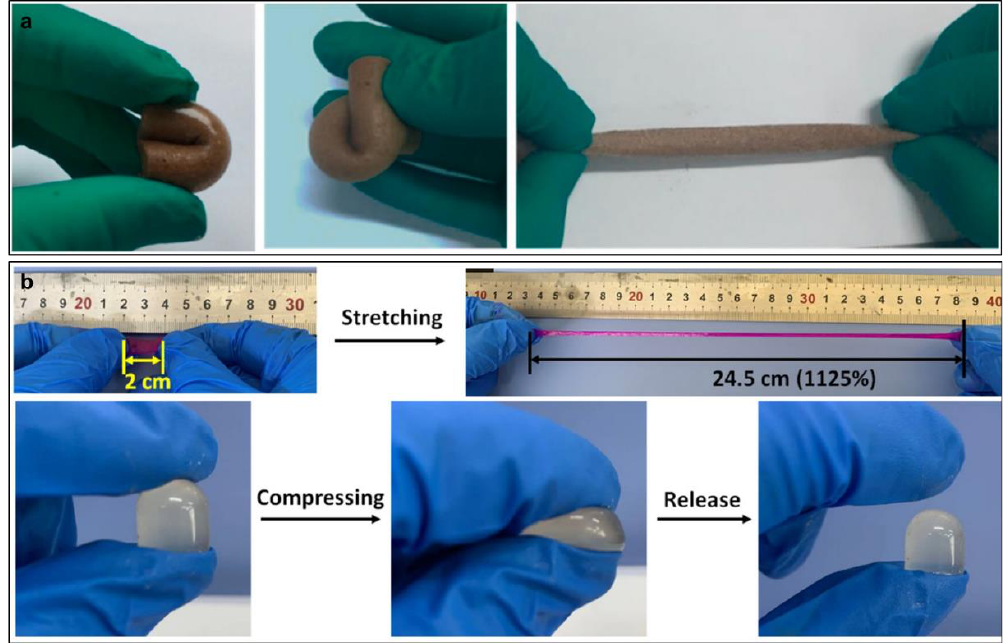
Figure 1. ( a ) Porous CPHs with PVA and GO exhibit extraordinary mechanical properties: bend, curl and stretch (reprinted with permission from ref. [28]); and ( b ) mechanical features of PAA–OSA–AG hydrogels under manual stretching and compressing (reprinted with permission from ref. [35]).